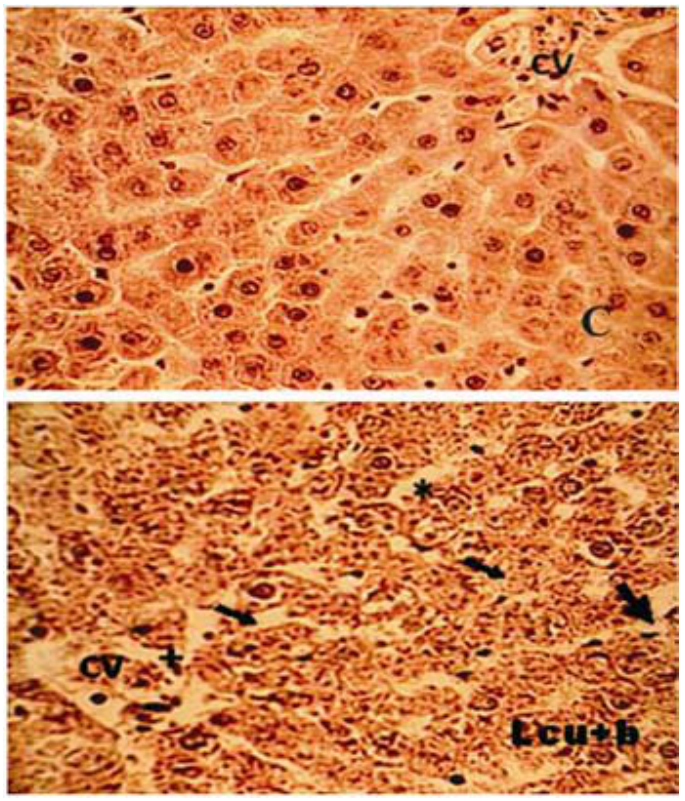
Figure 8. Liver sections of controls (C) and treated (Lcu+b) rats fed 10% L. lagocephalus cooked meat with cooking